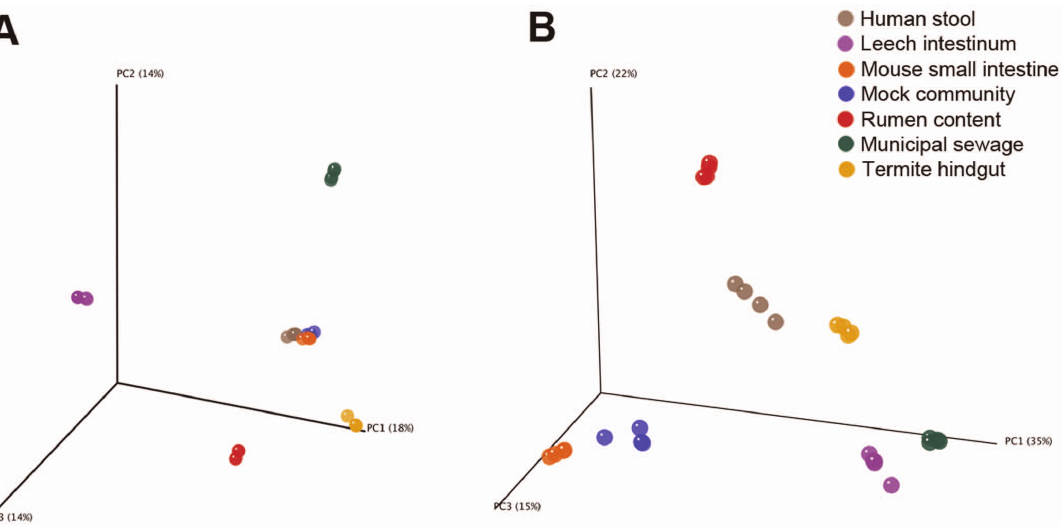
Figure 3. Beta diversity analysis of all datasets. Three dimensional principal coordinates analysis plots showing the relatedness of datasets using either the Bray-Curtis (A) and weighted UniFrac (B) metric. Individual datasets are represented at spheres which are colored according to their sample source as follows: human stool – brown, leech intestinum – purple, mouse small intestine – orange, mock community – blue, non-adherent rumen contents – red, mixed liquor – green, termite hindgut – gold.